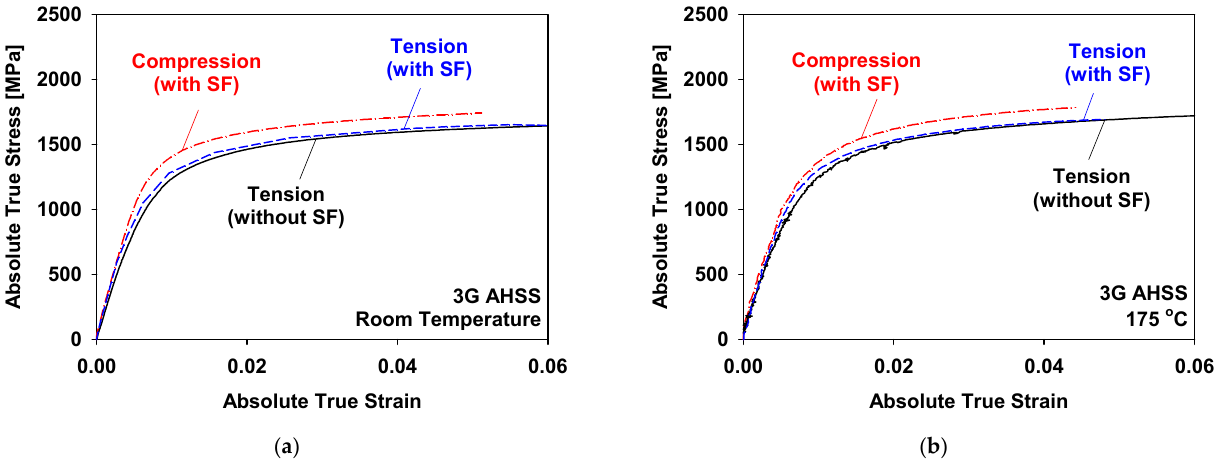
Figure 16. Apparent absolute true stress–strain curves of 3G AHSS at ( a ) room temperature, and ( b ) 175 °C.